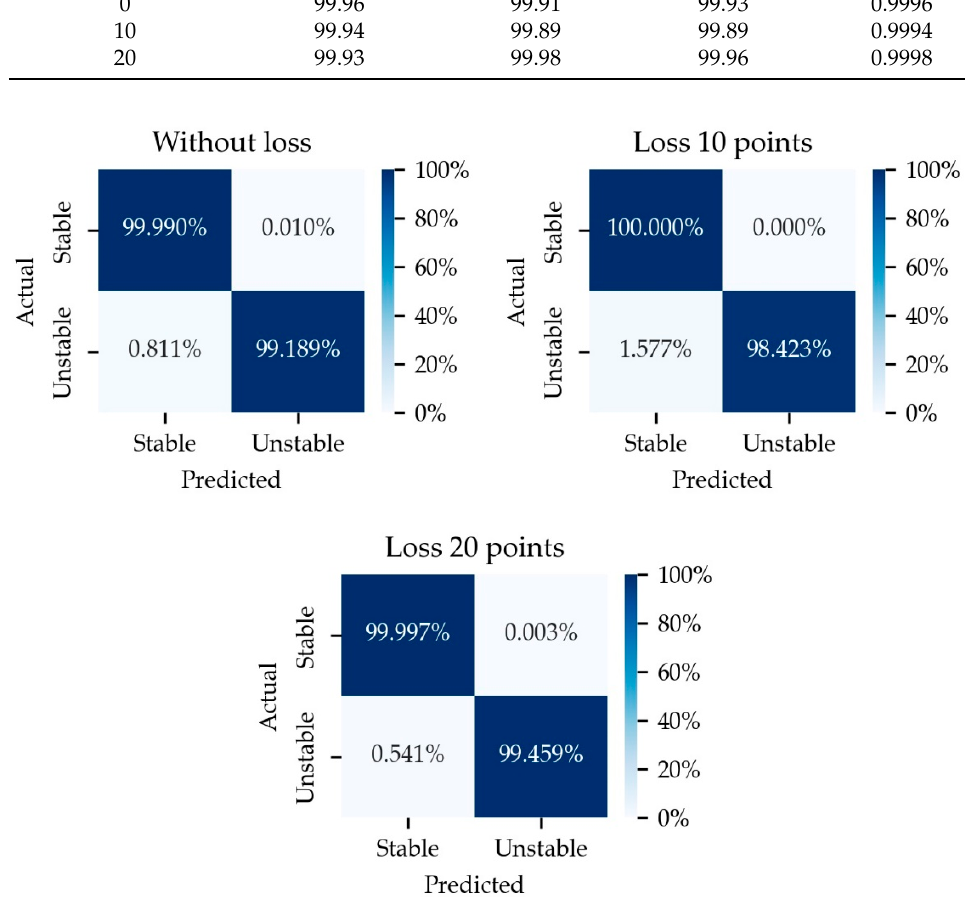
Figure 10. Recapitulation of normalized confusion matrix for the effect of data loss. With the missing data, the magnitude and angle of the voltage in the data used will change the data pattern. This makes the model process different data according to the number of missing data points so that the performance of the resulting model does not